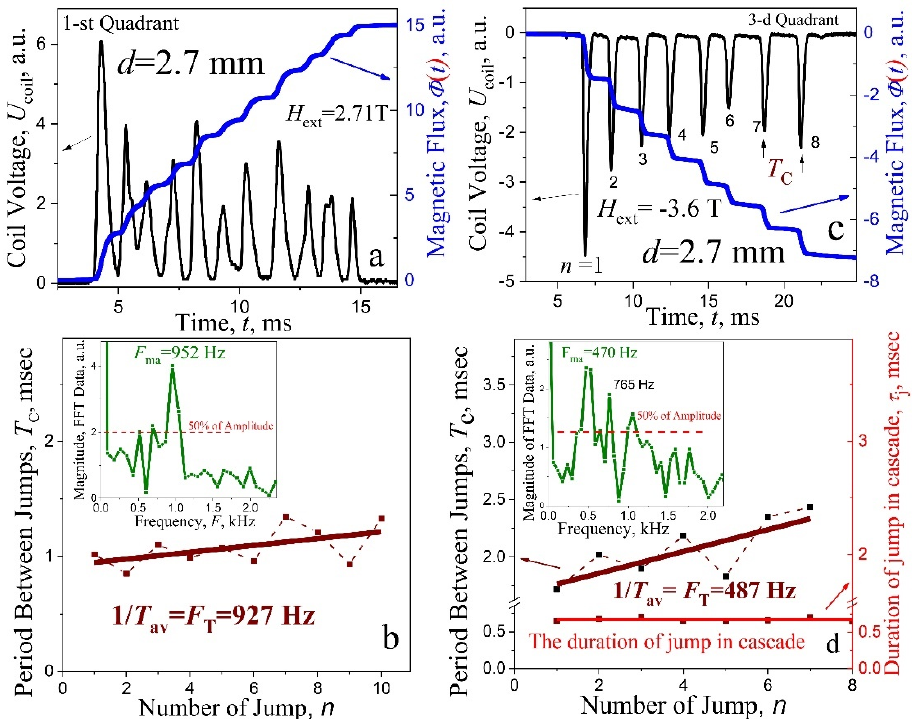
Figure 6. ( a , c ) The voltage impulse U coil ( t ) at the avalanche in screening ( a ) and in trapping ( c ) regime (left ordinate) and multi-step “stairway” structure of magnetic flux Φ ( t ) (right ordinate); ( b , d ) main frame—periods T c between jumps in cascade vs number of jumps n . The duration of separate flux impulses in the cascade is given by bottom line in ( d ). Data for the magnitude in fast Fourier transformation of signal U coil ( t ) are presented in the inserts ( b , d ); d = 2.7 mm, T = 2 K.